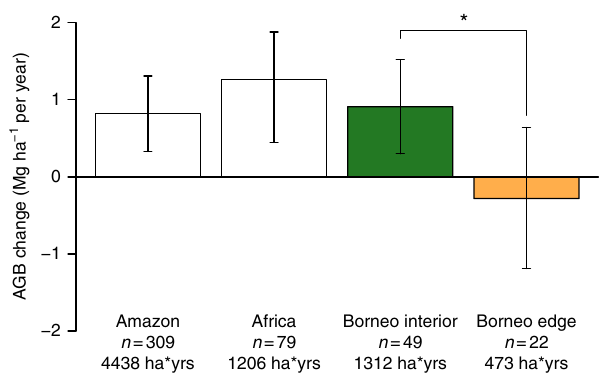
Fig. 3 Above-ground live biomass change rates in pan-tropical structurally intact forests. Results for Borneo (this study) were based on linear mixed effects (LME) model estimates for the mean period of 1988 – 2010 (spanning 1958 – 2015), showing contrast between forest interior plots and edge-affected plots. The most recent published estimates for similar periods for Amazon 10 and tropical Africa 10 are shown for comparison. All estimates are based on direct, ground measurements, with the number of long-term inventory plots and total monitoring effort (in ha years) indicated. Bars are 95% CIs. Only the difference between Borneo interior and edge plots was tested statistically where asterisk indicates signi fi cant difference ( P = better represented by asymptotic (Akaike's Information Criterion, AIC = 222) and hockey-stick (AIC = 222) models than by either the simple linear (AIC = 227) or null (AIC = 228) models. The hockey-stick model threshold was 448 m (95% bootstrap con- fi dence interval (CI) 393 – 908 m; Fig. 2a), giving 49 forest interior and 22 edge plots. For this division of plots, using an LME model